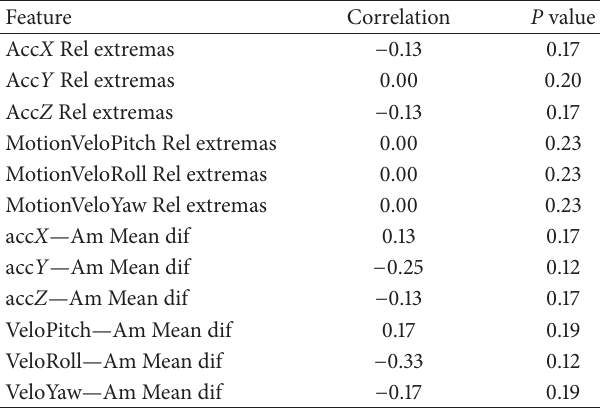
Table 1: Correlations and P values between the different versions of the game and the movement features. The P values are obtained from a binomial distribution with expected probability of 0.5.